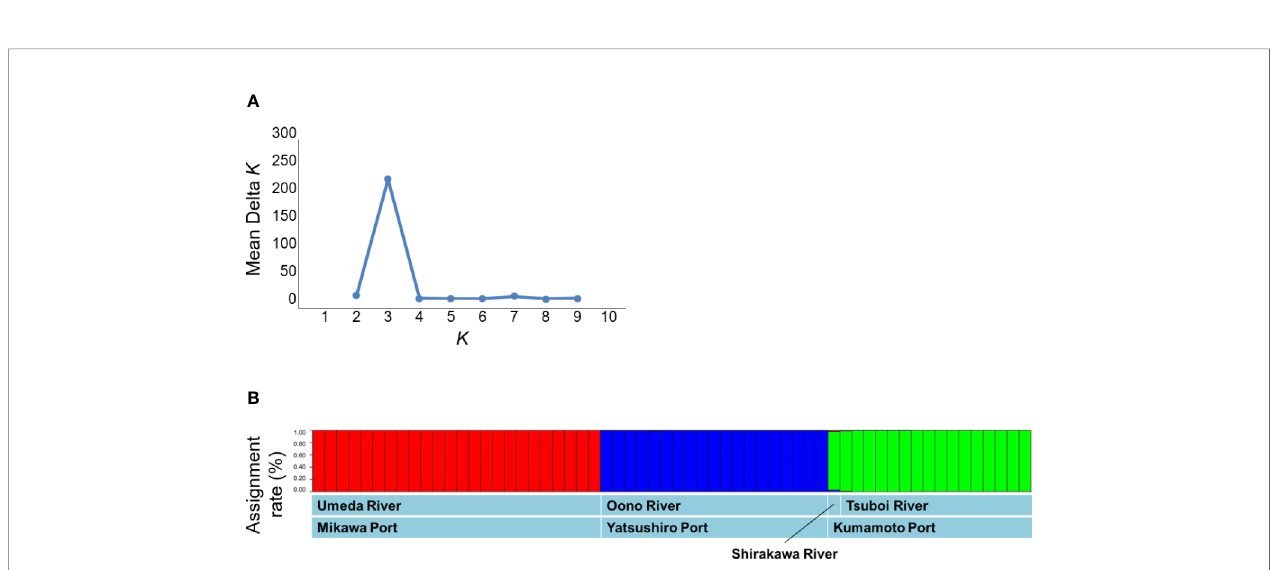
FIGURE 4 | Population structures based on the microsatellite mutation among the genes sampled from Spartina alterni fl ora populations in Japan using Bayesian estimation. (A) The estimation of the optimum number of clusters based on D K. (B) The assignment of each individual into the clusters using STRUCTURE analysis. The vertical axis in panel B shows attributed rates of each sample collected in S. alterni fl ora local